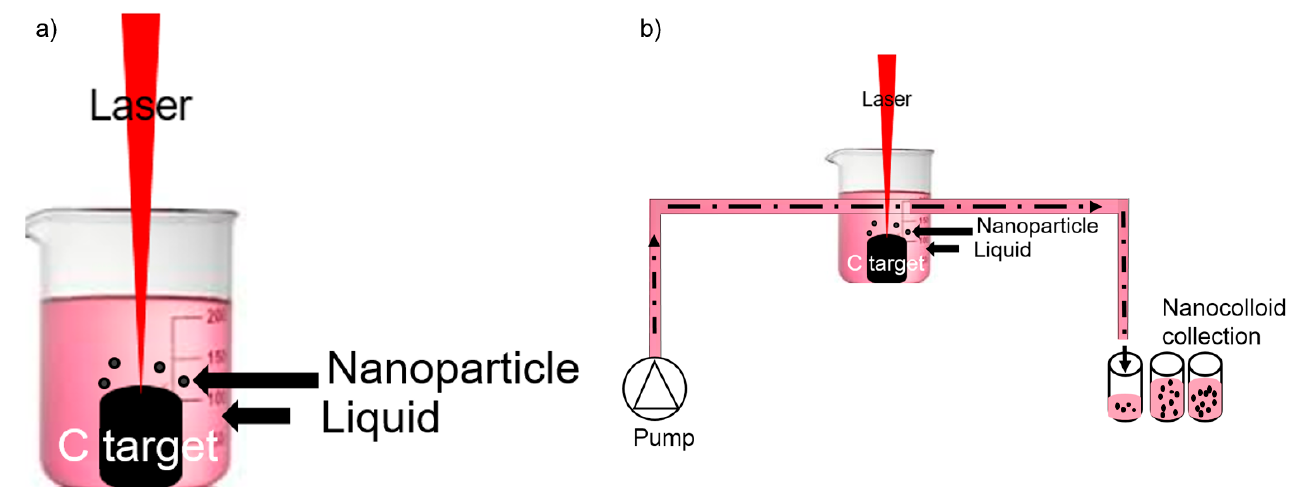
Figure 2. The two modes of pulsed laser ablation in liquid (PLAL): ( a ) batch mode and ( b ) flow